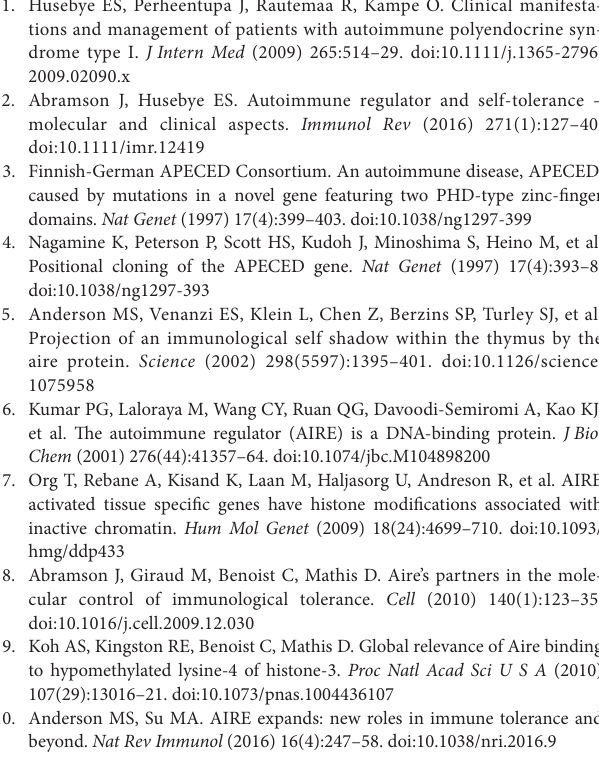
TaBle s2 | List of autoimmune regulator (AIRE)/Aire-regulated genes with genes showing conservation in TEC 1A3 data set and at least three murine data sets. Data compiled from repertoires of AIRE and Aire-regulated genes determined from t -test analysis of microarray data generated from TEC 1A3 cells (GSE35244), and medullary thymic cells from C57BL/6 mice, BALB/c mice and NOD mice for two datasets [GSE12073 (38) and GSE8563 (39)]. All possible permutations of microarray probes (when more than one for a particular conserved gene) are shown. TaBle s3 | List of gene-specific primer sequences used for QPCR assays, with PrimerBank (49) reference number where